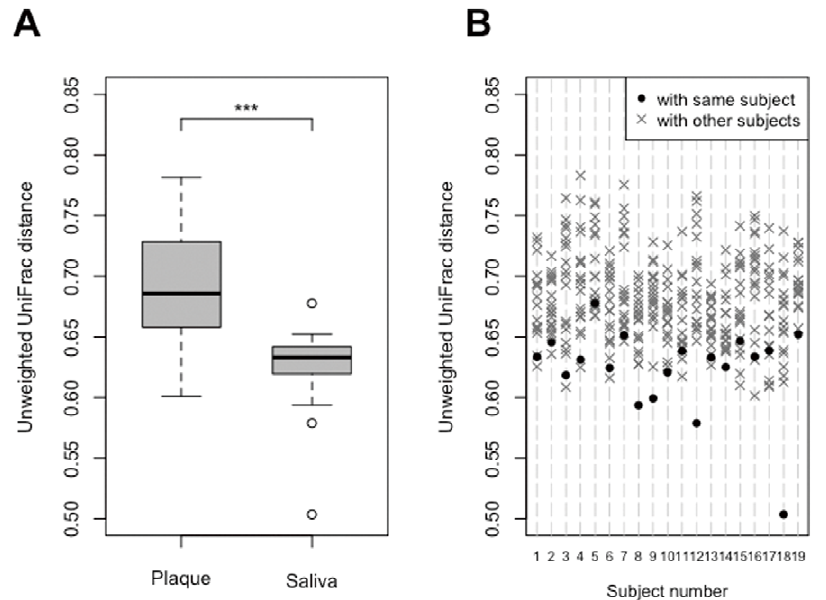
Figure 2. Unweighted UniFrac distance between pre- and post-therapy samples. (A) Degree of temporal variation in supragingival plaque microbiota and salivary bacterial population. Significant differences between the supragingival plaque microbiota and salivary bacterial population N were assessed using paired t-tests. ***P , 0.001. (B) Unweighted UniFrac distance between pre-and post-therapy saliva samples. UniFrac distance of ) and those of the other 18 individuals ( 6 ) were plotted for each subject. A the combination of pre- and post-therapy of the same individual ( significant difference was observed between the UniFrac distance of the combination of pre- and post-therapy of the same individual and those of the other 18 individuals by Student’s t -test ( P , 0.001).